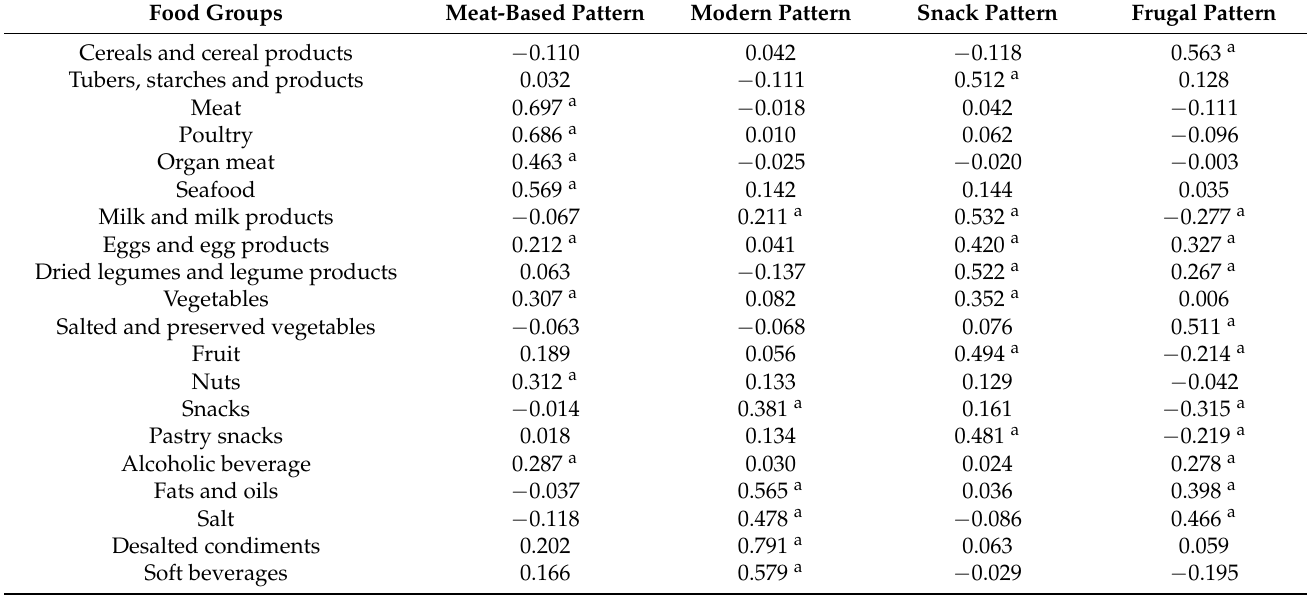
Table 1. The factors of dietary patterns identified by factor analysis in the